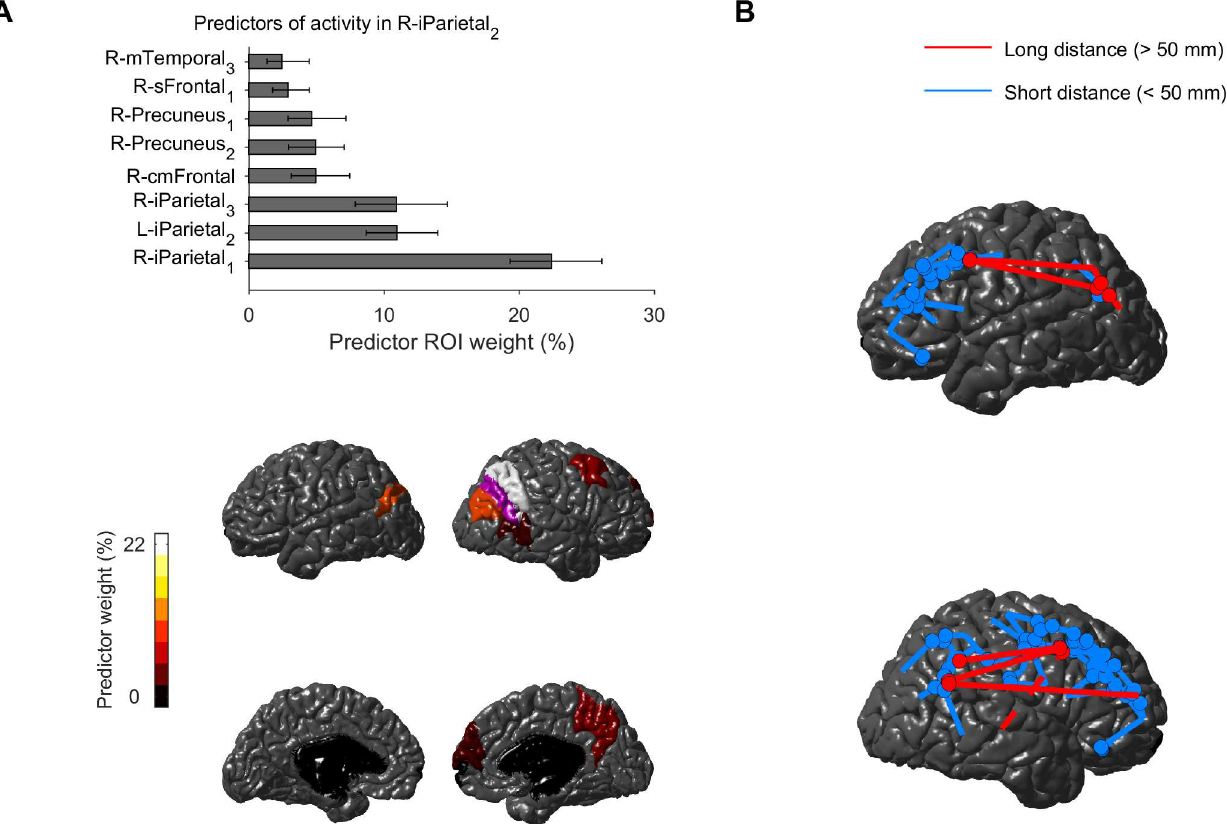
Fig 5. Key predictor ROIs reveal integration networks during resting-state activity. A. The weightof key predictorROIs for modelsof right inferior parietalcortex 2 (bootstrapping estimated mean and95% confidenceintervals). Bottom–lateral and medialviews of left/right hemispheres, showingright inferiorparietalcortex 2 (magenta) and the weightof its key predictorROIs. B. Integrator ROIs (with large multiregional prediction gain) andtheir key predictorROIs formed interconnected integrationnetworks. Short-distance dependencies (distance < 50 mm) are shown in blue, and long-distance dependencies ( > 50 mm) are shown in red. Dashedlines are inter-hemispheric.HomotopicROIs were often amongthe key predictorsof integrator ROIs but their dependencies are not shownin this figure.